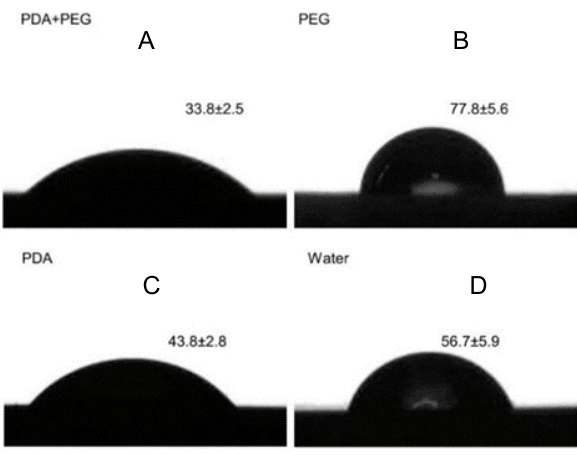
Figure 1. Contact angle (°) of PDA + PEG, PEG, PDA, and water on a hydroxyapatite disk. ( A ) PDA + PEG; ( B ) PEG; ( C ) PDA; ( D ) Water. ( A < C < D < B ; p < 0.001) PDA: polydopamine, PEG: polyethylene glycol.